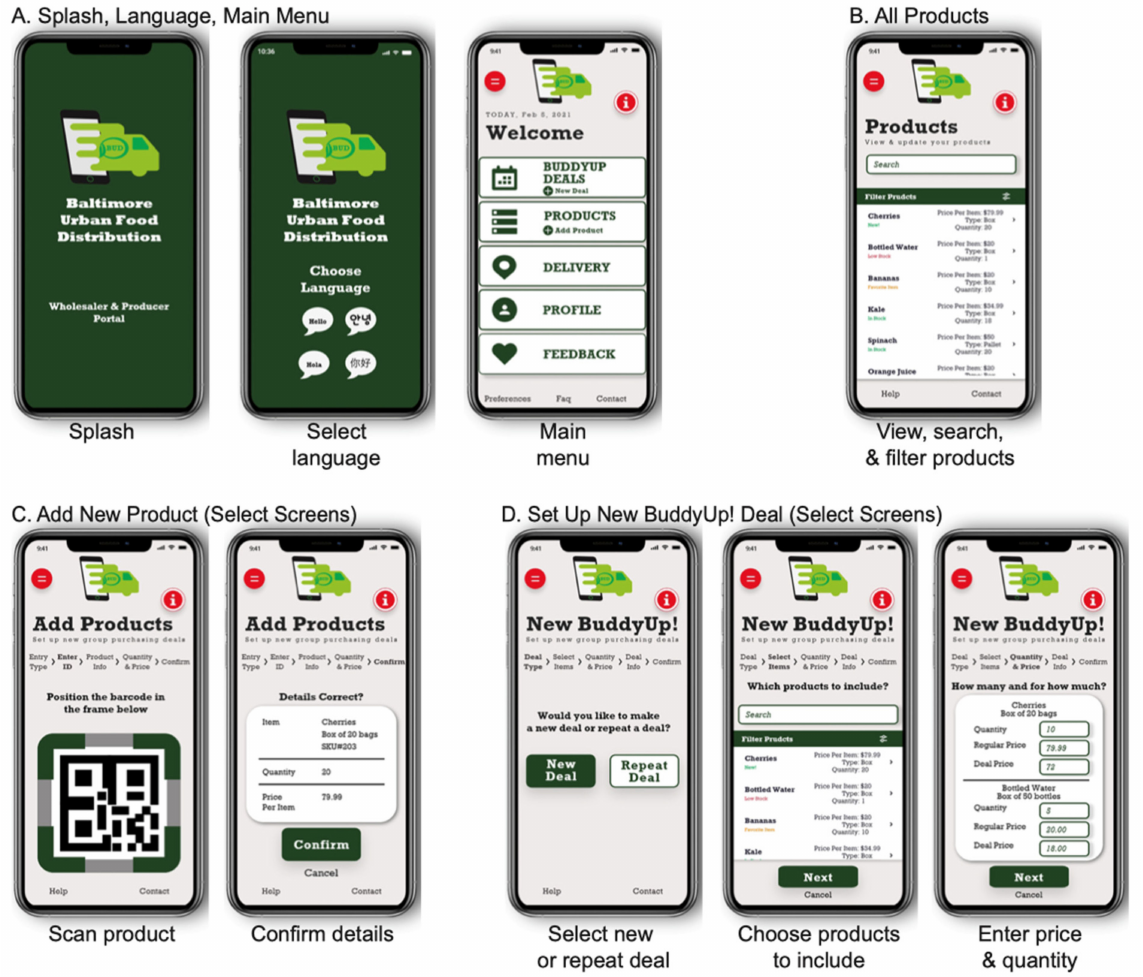
Figure 2. BUD producer and wholesaler screen